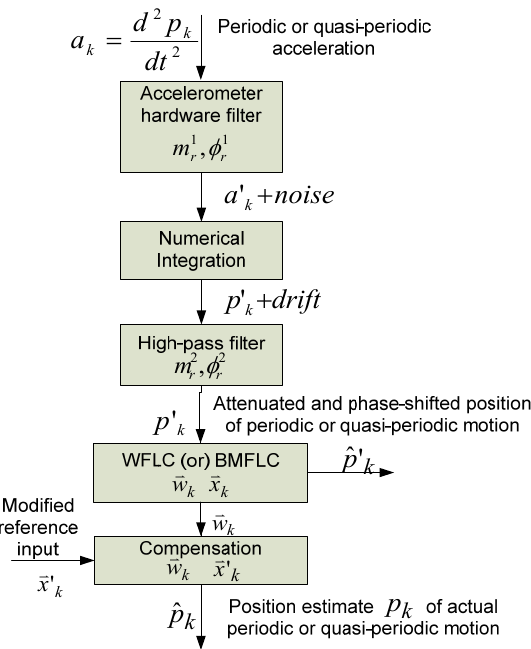
Figure 3. The block diagram showing the steps in estimation of position from accelerometer’s